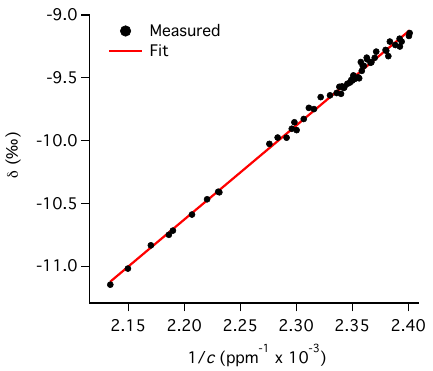
Figure 1. An example Keeling plot from the set described in Sect. 3.3, showing 55 measurements made on the night of 25 May 2011, spanning a CO 2 range (cid:49)c = 52ppm, with measure- ment error standard deviations of ε = 0 . 05ppm and η = 0 . 02‰.